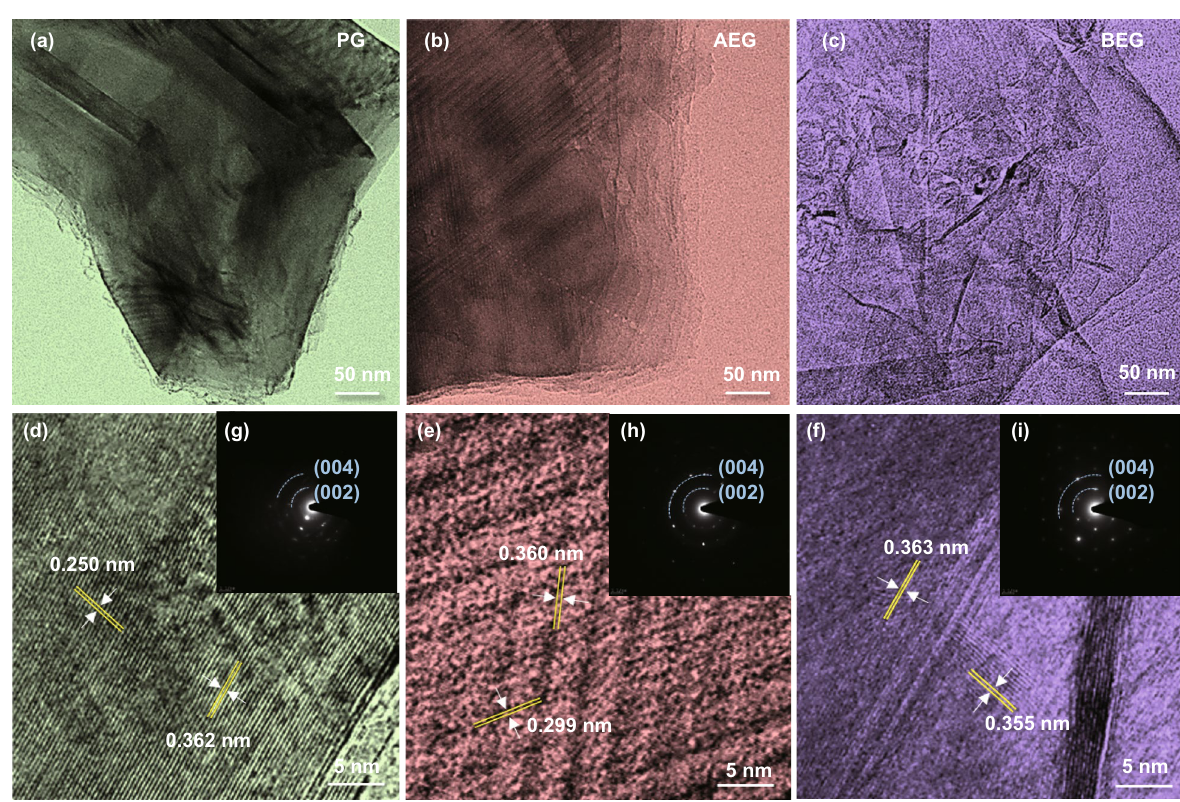
Fig. 2 a–c FE-TEM images and d–f HRTEM images of PG, AEG, and BEG. g–i SAED patterns of the corresponding